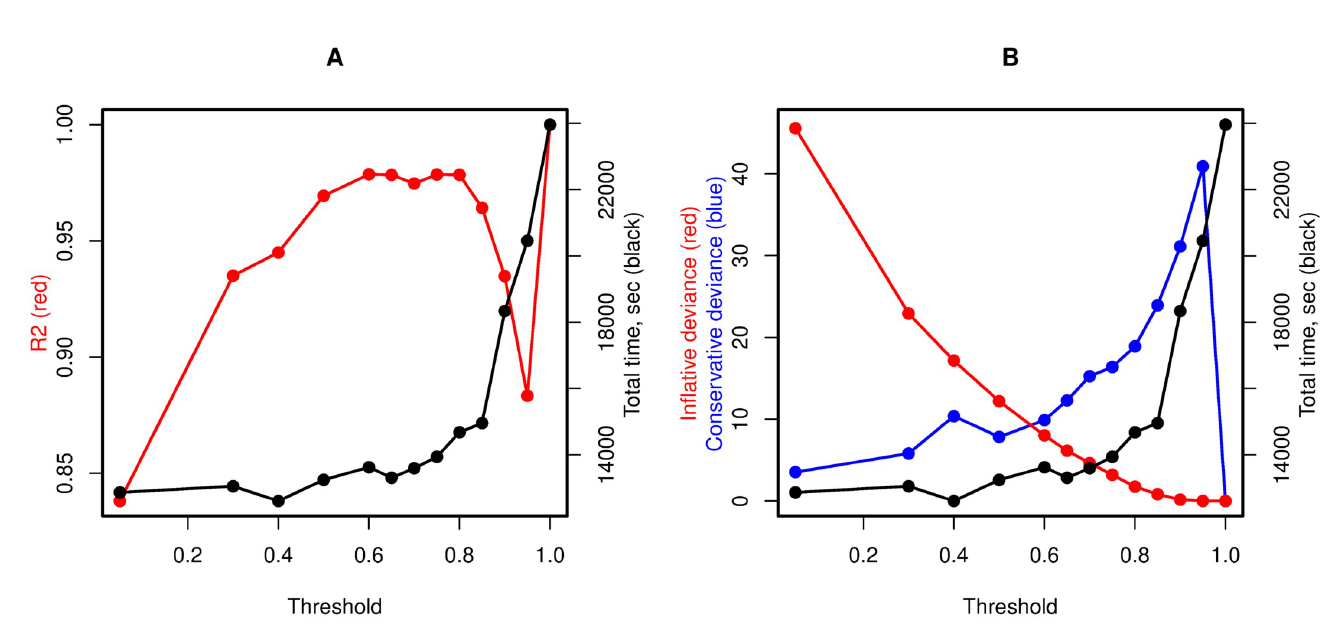
Fig 2. Determination coefficient and deviances of approximated SKAT statistic related to the threshold value. (A) Determination coefficient ( R 2 ) between–log10(P value) of original and approximated tests shown in red. (B) Deviances indicating inflation and conservativeness of approximated test statistics compared with original shown in red and blue,